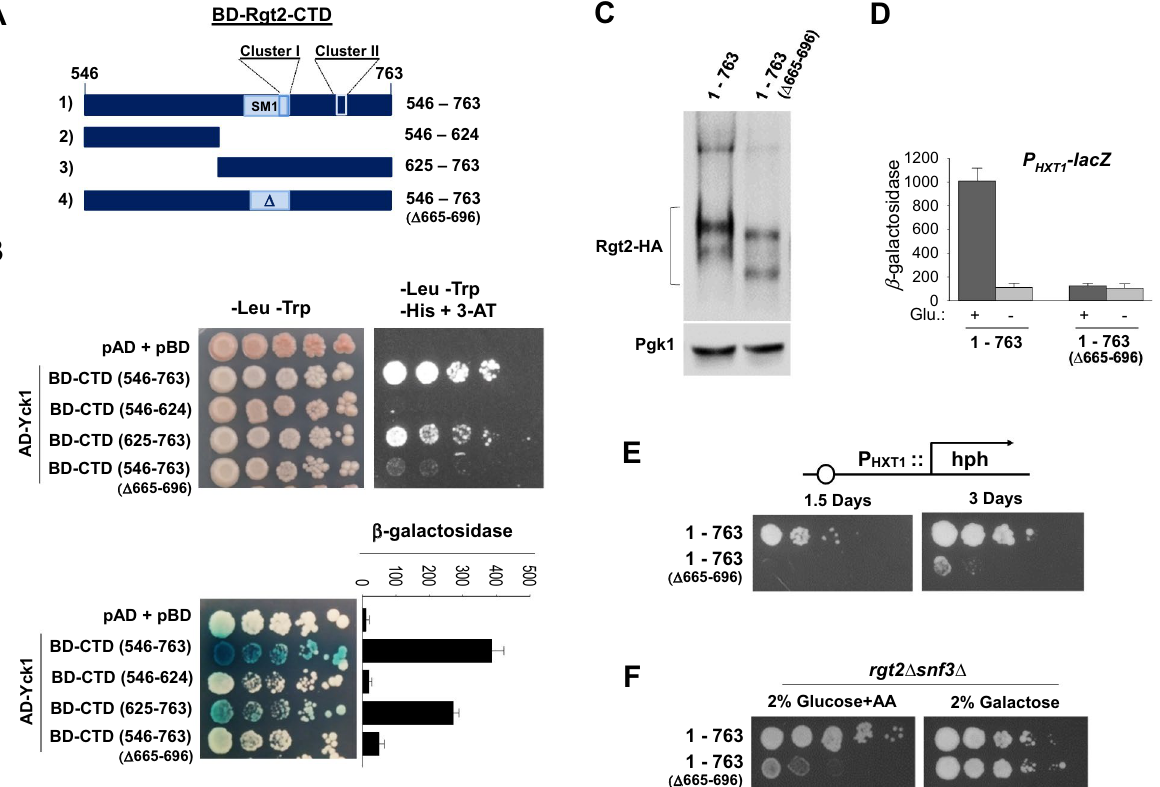
Figure 5. Rgt2 interacts with Yck1 through its C-terminal domain. ( A ) The yeast strain PJ69-4a was co-transformed with AD-YCK1 (JKP369) and either BD-RGT2 (JKP367) or indicated BD-RGT2 mutant constructs (JKP383, JKP387 and JKP416). ( B ) Positive interaction between AD-Yck1 and BD-Rgt2 was confirmed by expression of the GAL-HIS3 (− His + 3-AT) and GAL-lacZ reporters (β-galactosidase). (C) Western blot analysis of protein levels of wild-type Rgt2 (JKP253) and a truncated Rgt2 (Δ665–696, JKP408). Cells were grown in glucose (2%) or galactose (2%) and processed from Western blotting as described in Fig. 1A. ( D ) The WT strain (BY4742) strain was cotransformed the HXT1 - lacZ reporter (pBM3212) with plasmid expressing either wild-type Rgt2 (JKP253) or a truncated Rgt2 (Δ665–696, JKP408). β-Galactosidase activity was assayed as described in Fig. 1B. ( E , F ) The P HXT1 -hph reporter strain (KLS76) expressing indicated Rgt2-HA proteins was scored for growth in a SC-2% glucose plate supplemented with 200 µg/ml hygromycin ( E ). The rgt2 snf3 double mutant (MSY441) expressing indicated Rgt2-HA proteins were spotted on 2% glucose plate supplemented with Antimycin-A (AA, 1 µg/ml) and SC-2% galactose plate ( F